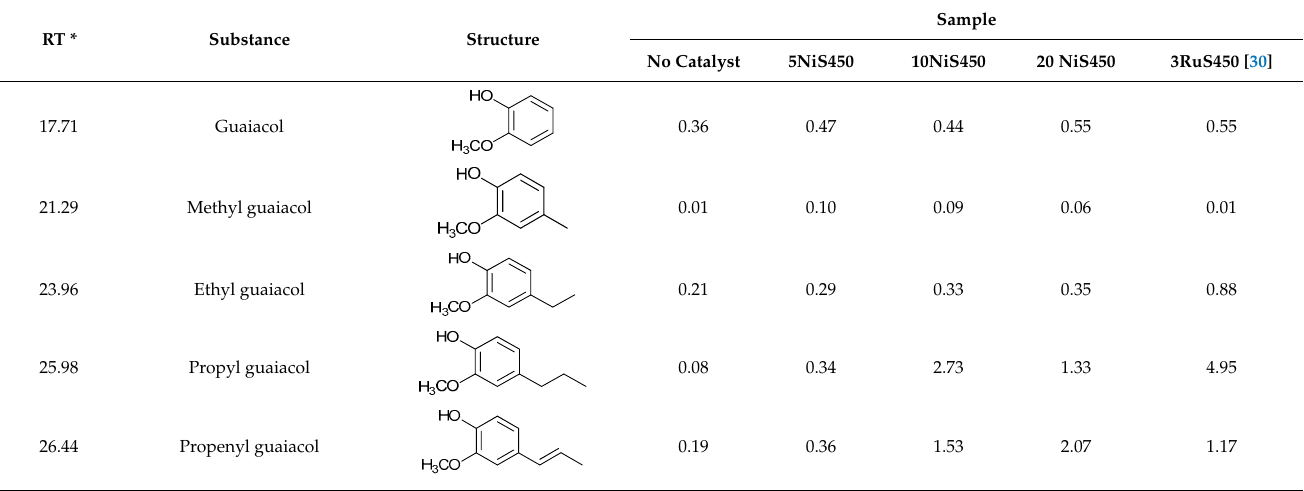
Table 5. Effect of the metal loading on the yields of main monomers (225 ◦ C, 3 h).